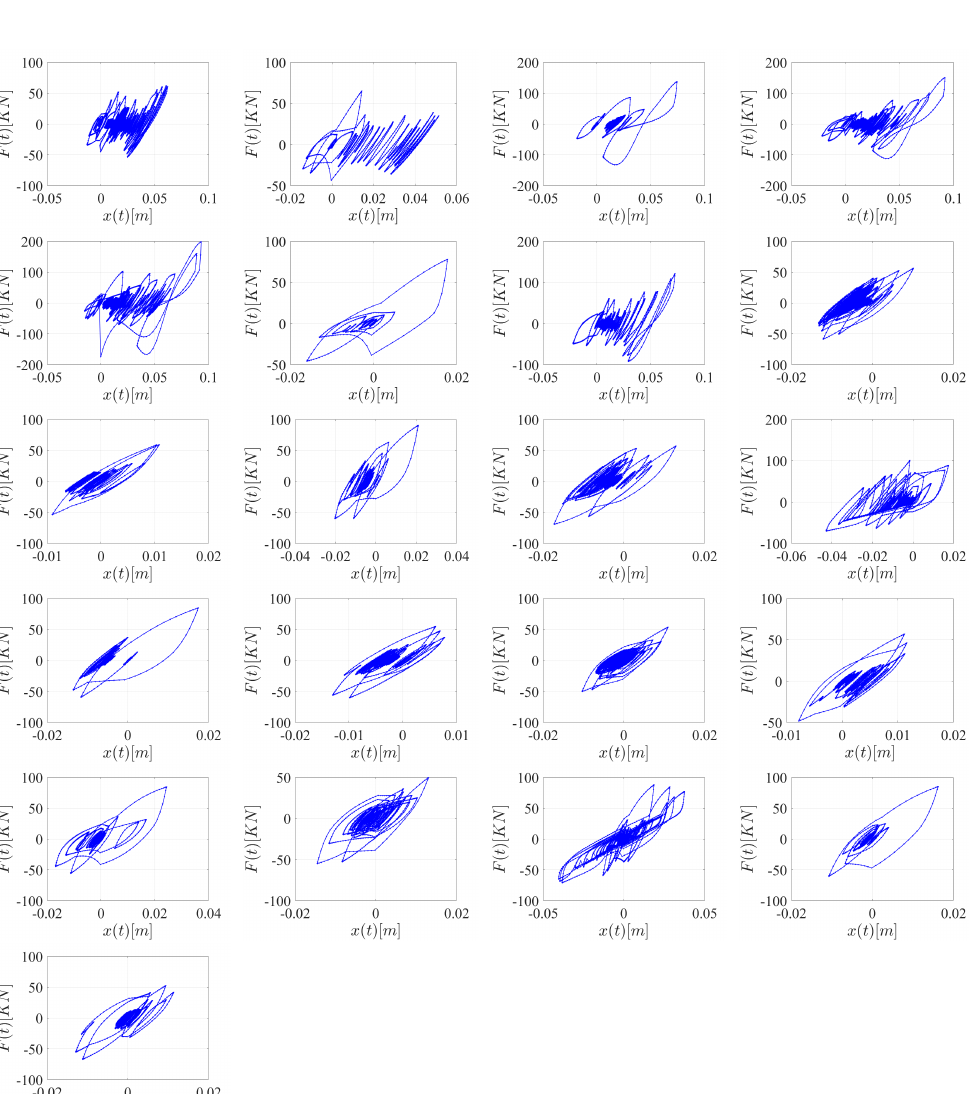
Figure 6. Hysteresis loops of the first CLT wall configuration. From ( a – g ), ( h – n ) and ( o – u ), the re- sponses of the I.1, I.2 and I.3 CLT wall configurations, respectively, are reported. Each set corresponds to the particular system’s response to the 7 selected accelerograms. The CLT wall panels’ dissipative capacity is evaluated in terms of the maximum dissi- pated hysteretic energy. Thus the seismic performance of the different wall’s configurations (different anchoring systems, single and coupled walls, and different types and number of screws to connect the panels) is